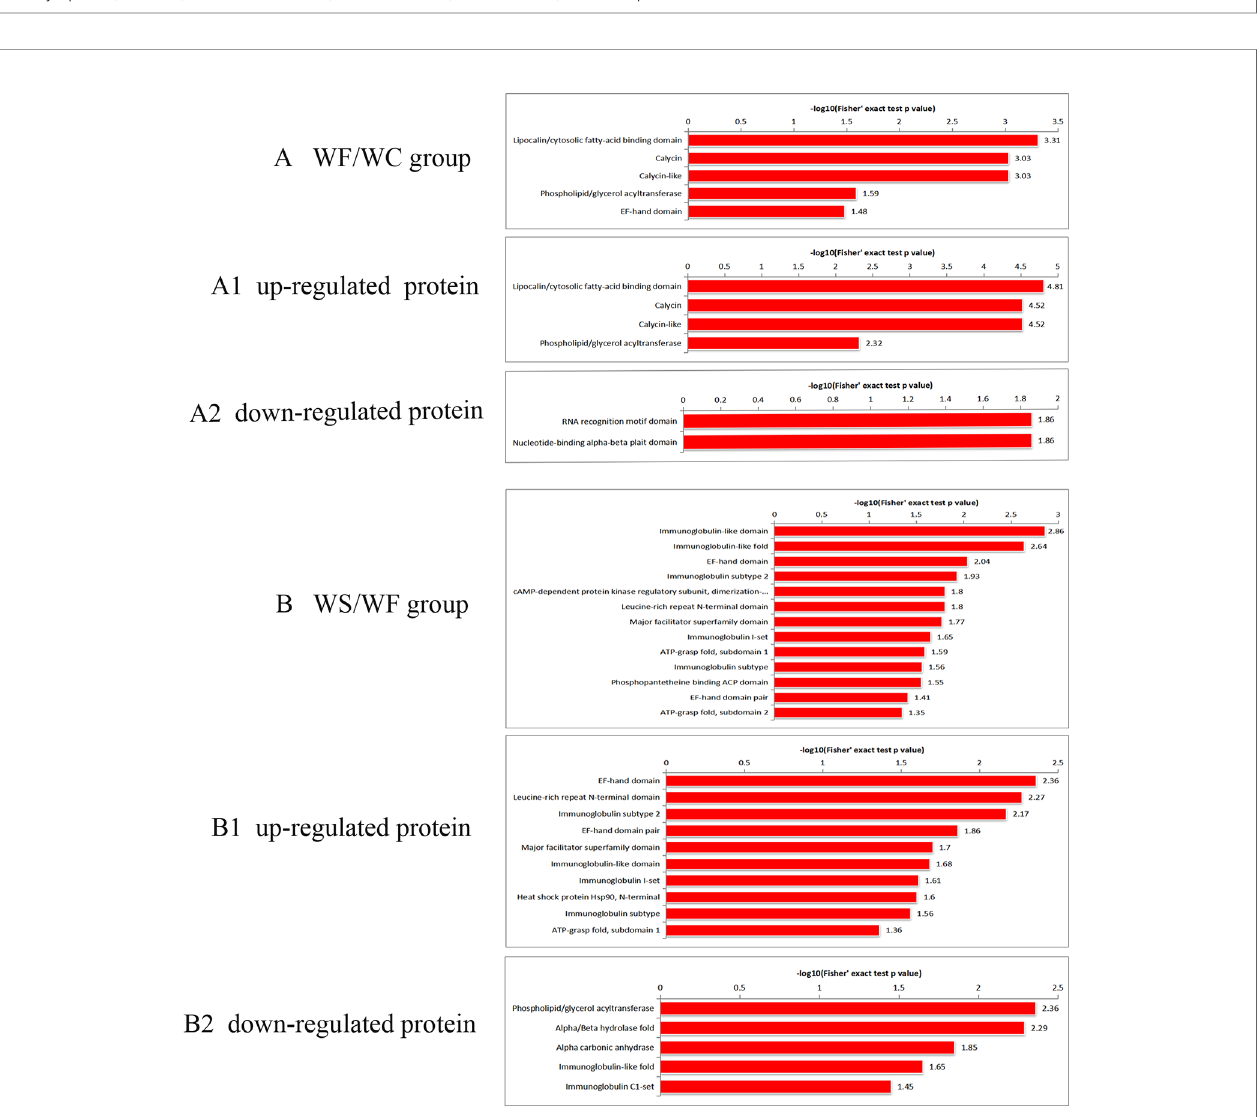
FIGURE 6 | Protein domain enrichment plot of differentially expressed proteins. (A) The differential protein domain in WF/WC group; (A1) The domain of up-regulated protein in WF/WC group; (A2) The domain of down-regulated protein in WF/WC group; (B) The differential protein domain in WS/WF group; (B1) The domain of up- regulated protein in WS/WF group; (B2) The domain of down-regulated protein in WS/WF group. WC, normal diet; WF, high fat diet; WS, high fat diet + silibinin.